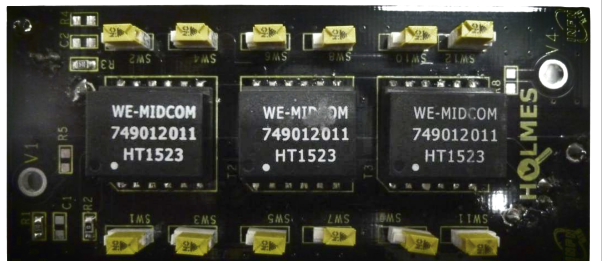
Figure 9. Equivalent circuit to the setup of Figure 8, when γ transformers are activated: The transformer input/output parameters are shown for this case.